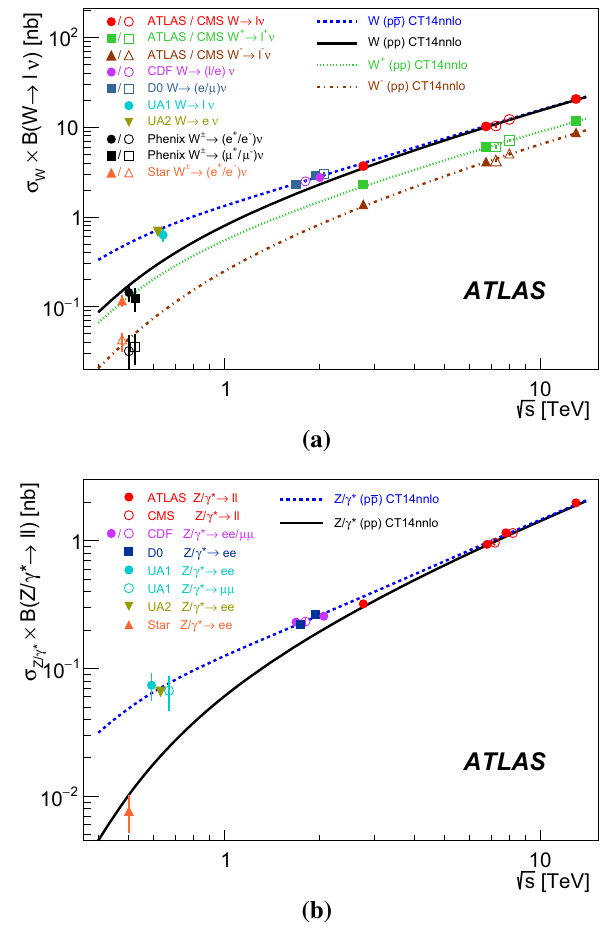
Fig. 4 The measured values of (a) σ W × B ( W → (cid:3)ν) for W + bosons, W − bosons and their sum and (b) σ Z /γ ∗ × B ( Z /γ ∗ → (cid:3)(cid:3)) for proton– √ s .Datapoints protonandproton–antiprotoncollisionsasafunctionof √ s are staggered to improve readability. All data points are at the same shown together with their total uncertainty. The theoretical calculations are performed at NNLO in QCD using Dynnlo 1.5 and Fewz 3.1 as described in the text. The theoretical uncertainties are not